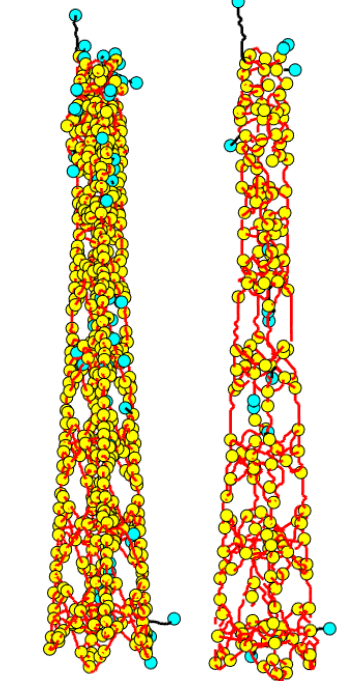
have been filtered, the skeleton is extracted and converted to a 3D graph. The Tables 8a and 8b show the numbers of nodes and beams in the graphs obtained with different parameters. Figure 9 shows two examples of graph representations.